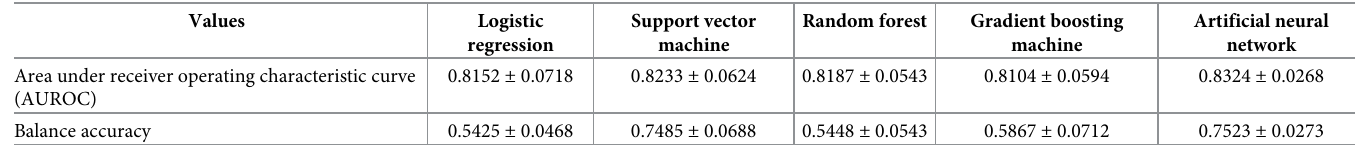
Table 3. Comparison of machine learning and deep learning models by 10-fold cross-validation for disease severity prediction in dengue virus type 2 infection.